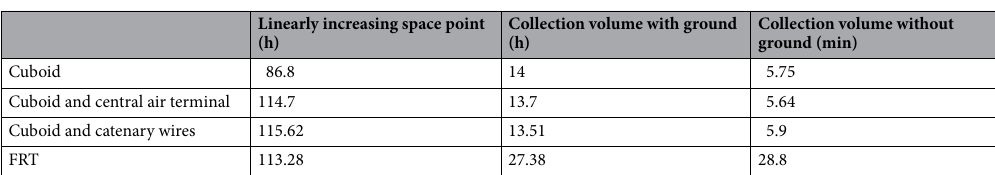
Table 2. DEGM computation time